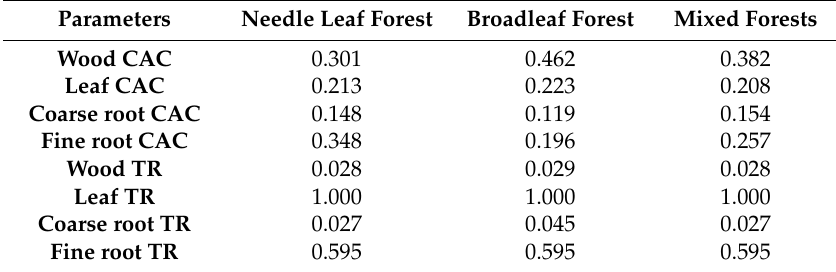
Table 2. Carbon allocation coefficients (CAC) and turnover rates (TR) used in the process-based BEPS